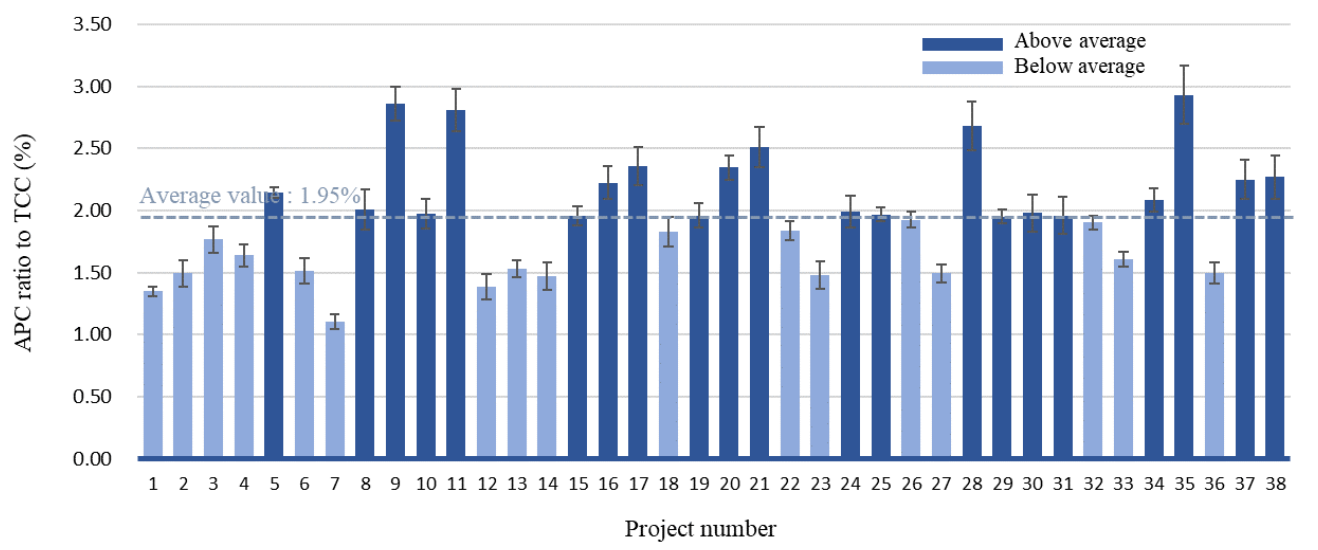
Table 7. Ratio analysis results.